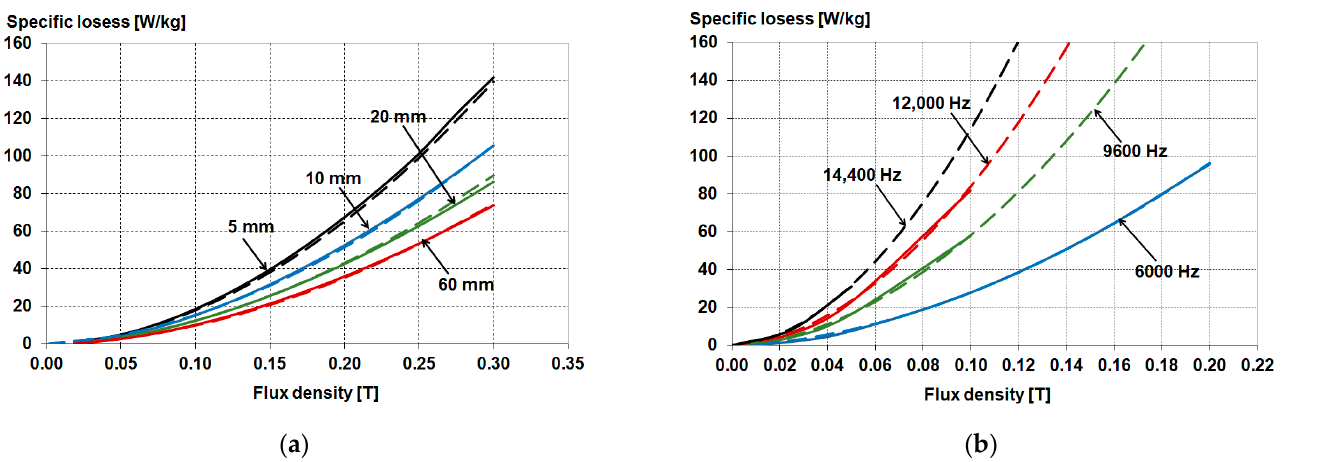
Figure 26. Measured and approximated loss characteristics of the M270-35A sheet for various widths of laser-cut sheet samples at a frequency of 4000 Hz (measured—solid line, estimated— dashed line) ( a ), and approximated loss characteristics for the laser-cut sheet sample M270-35A 10mm wide (dashed line) and measured on a 400/420mm laser cut annular sample (solid line), at frequencies 4000 Hz < f ≤ 14,400 Hz ( b ).